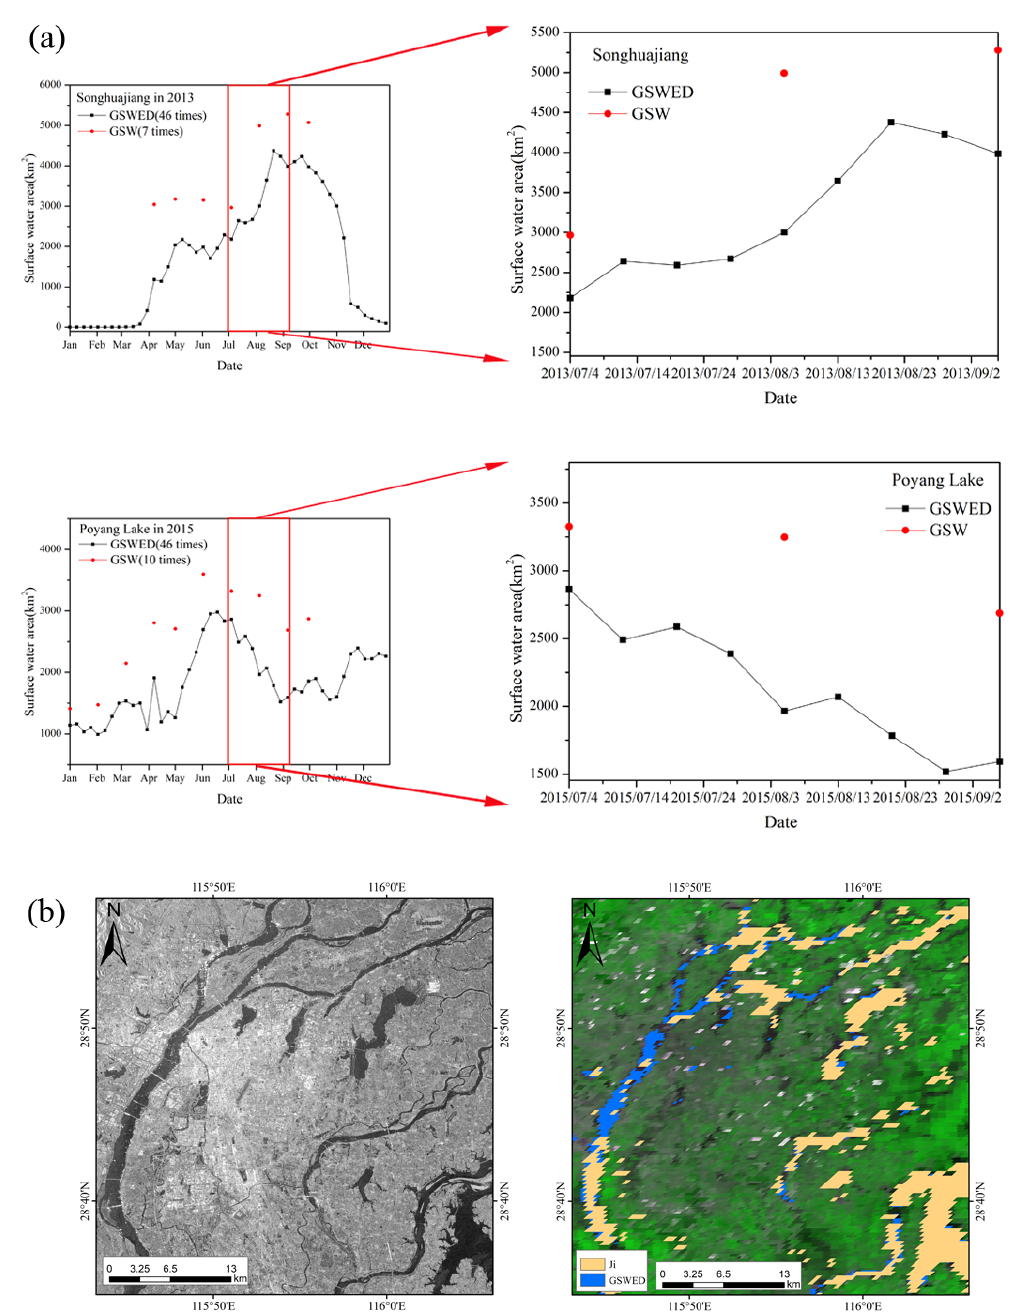
Figure 11. ( a ) Changes in surface water area of global surface water [25] and global surface water extent dataset in Songhuajiang basin in 2013 and in Poyang Lake in 2015, China; ( b ) surface water distribution of Ji et al. [26] and our dataset in Poyang Lake on June 26,